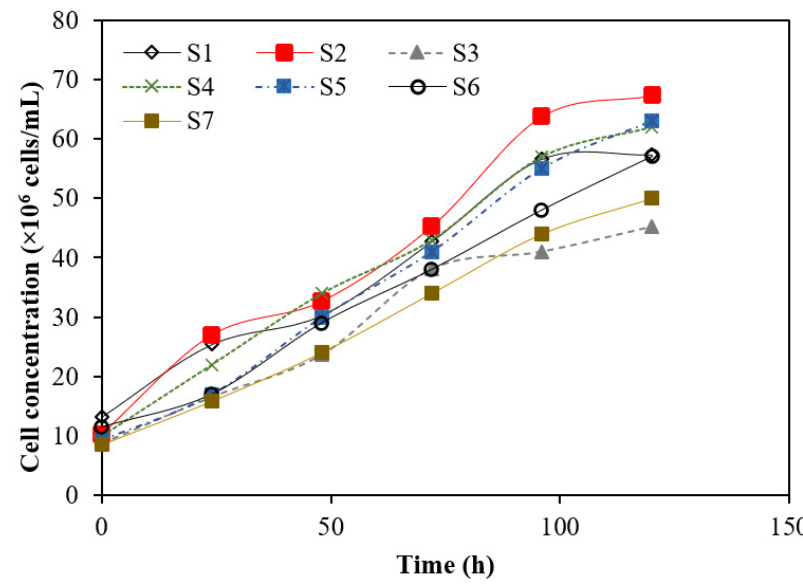
Figure 9. Cell concentrations of different strains over 120 h of SSF.